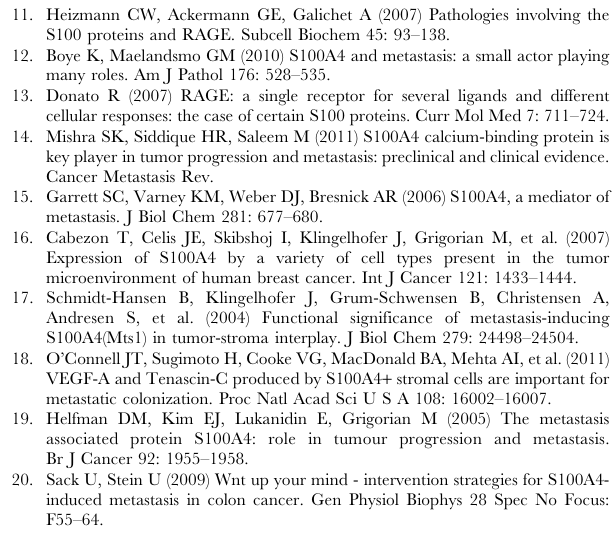
Figure S1 S100A4 and RAGE expression levels. A) Western-blot analysis of S100A4 and RAGE expression in M21 (mock vector and S100A4 overexpressed), MiaPACA-2 (mock vector and S100A4 silenced) and HUVECs cells. B) RT-PCR analysis of mRNA expression of S100A4 and RAGE. C) Secretion levels of S100A4 protein of M21, MiaPACA-2 and HUVECs cells determined by sandwich ELISA.